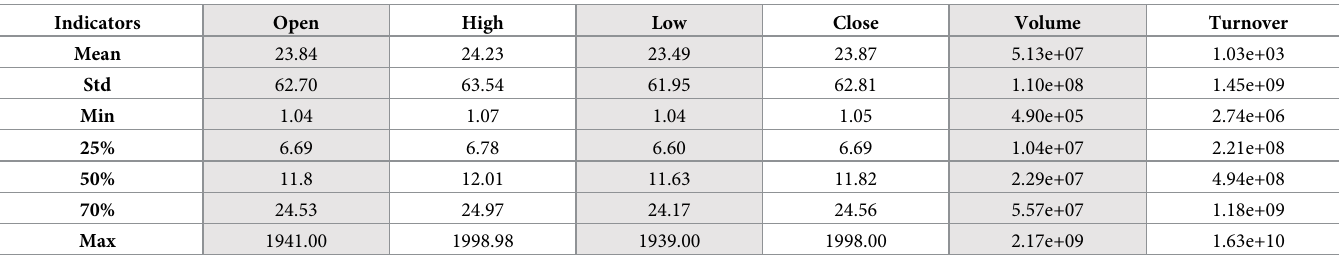
Table 3. Transaction data